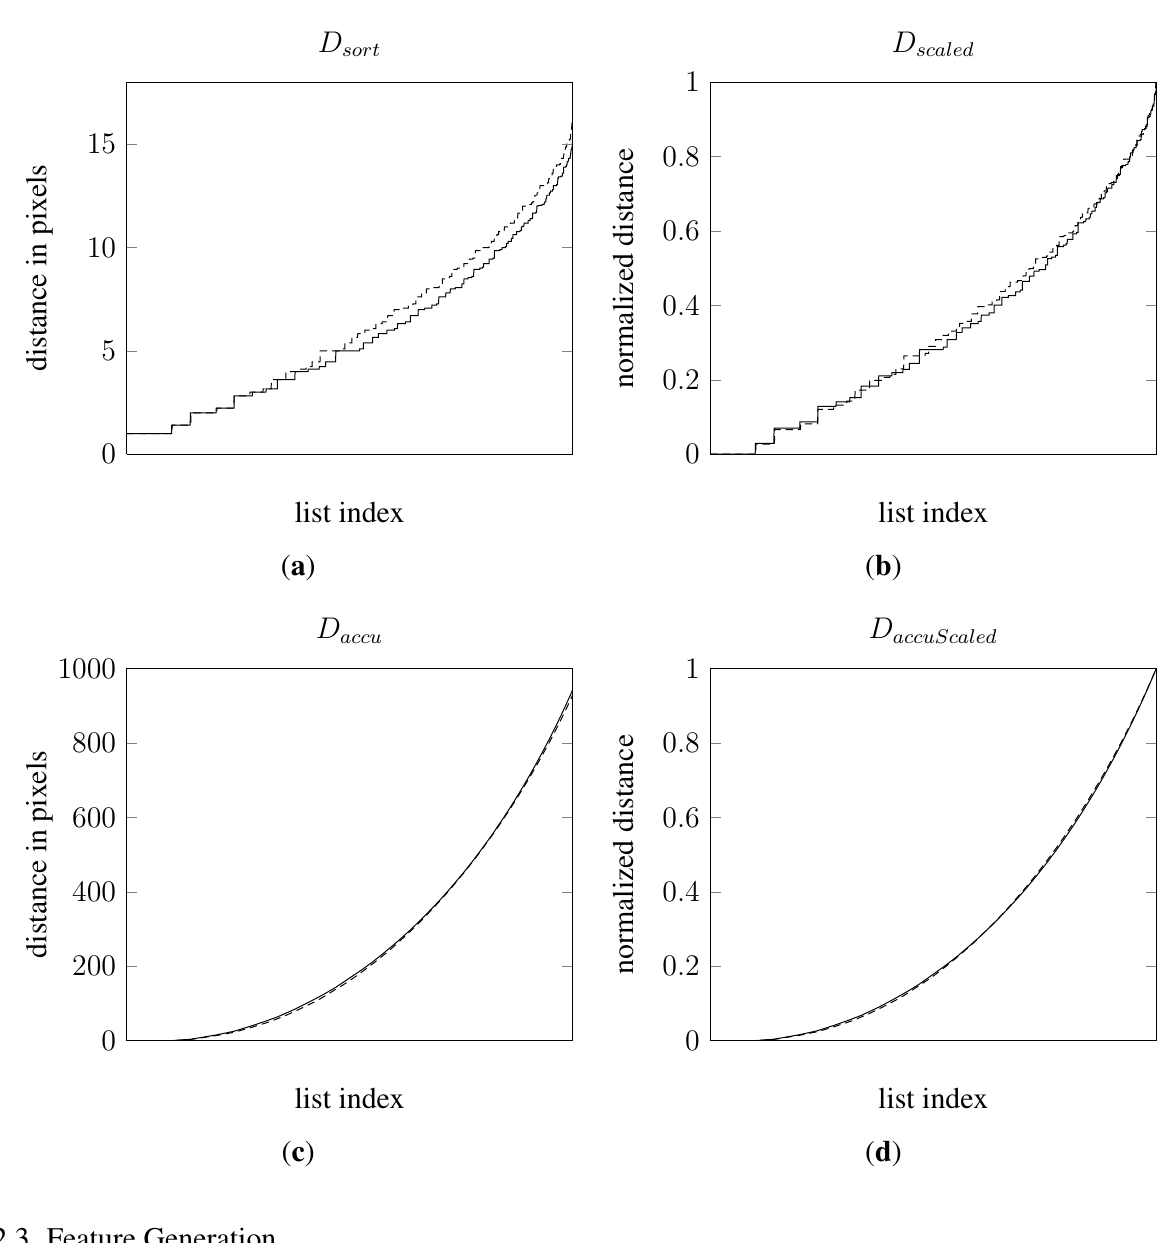
Figure 5. Comparison of the four data mappings for the nightshade and cornflower samples in Figure 4. Dashed lines originate from the nightshade sample and solid lines from the cornflower sample. ( a ) plot of sorted distances; ( b ) plot of sorted and scaled distances; ( c ) plot of sorted and accumulated distances; ( d ) plot of sorted, accumulated and scaled